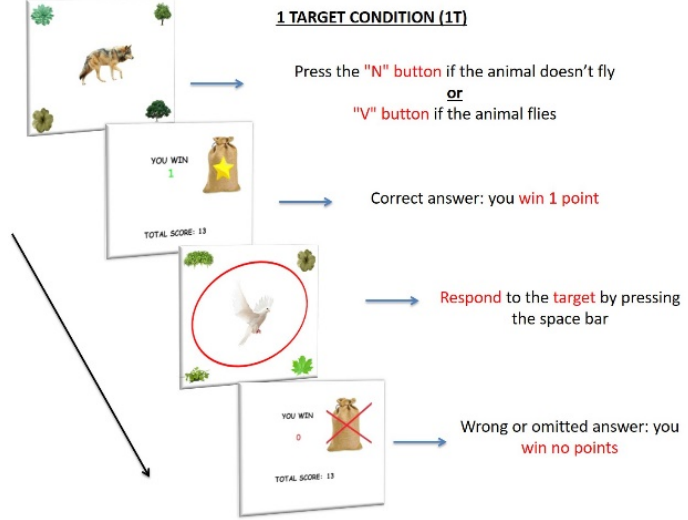
8 of 24 Figure 1. Procedure of Baseline condition (BC). The items consisted of 108 images of an animal located at the center of the screen; images of plants were located at the four corners of the screen. Participants had to press the “N” button when the image of a non-flying animal appeared on the screen and the “V” button when the image of a flying animal appeared on the screen (semantic decision task). Each stimulus appeared for 2 s. Participants received 1 RP for every correct answer and no RP for any wrong or omitted answer. 2.2.2.3. PM Conditions In the PM conditions, participants had to execute an event-based PM task (12 trials) while performing the ongoing task (108 trials). Specifically, the ongoing task must be in- terrupted to be able to carry out the PM task, when the PM target appeared on the screen. 1T. Only one PM target was included, at the center of the attentional focus, without reward manipulation. For the ongoing task, participants had to press the “N” button